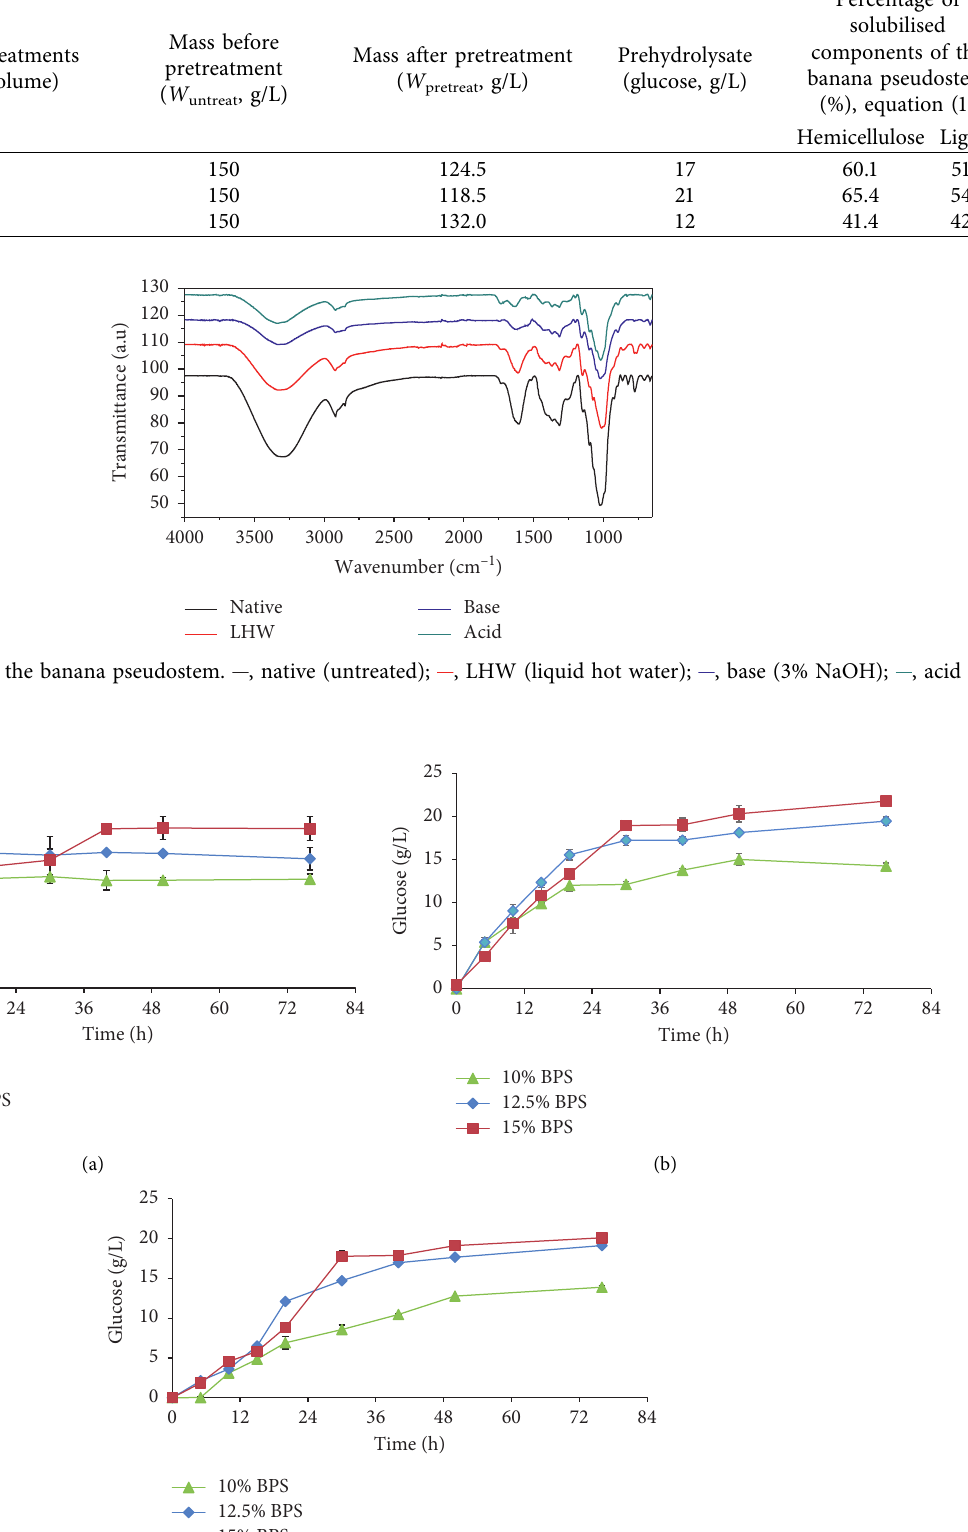
Banana pseudostem pretreatments